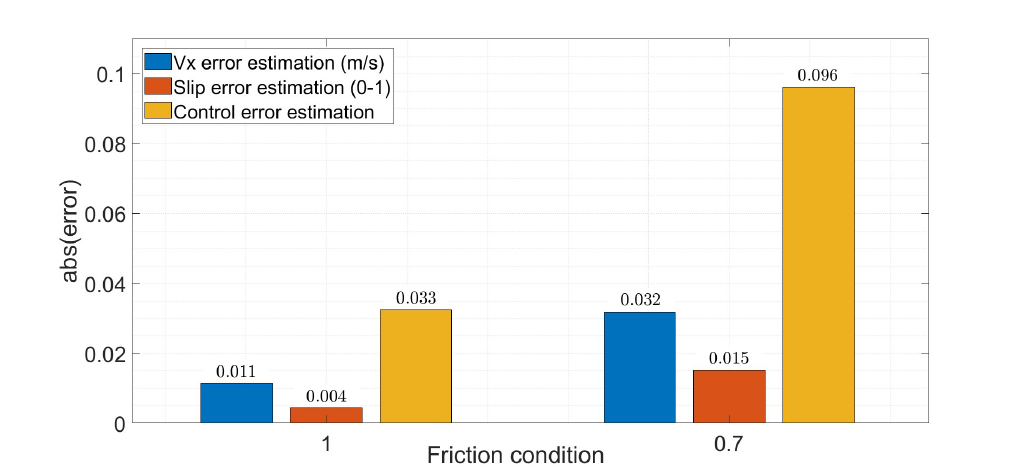
Figure 5. Influence on Slip Control of the error on speed estimation during full brake manoeuvre in high and low friction